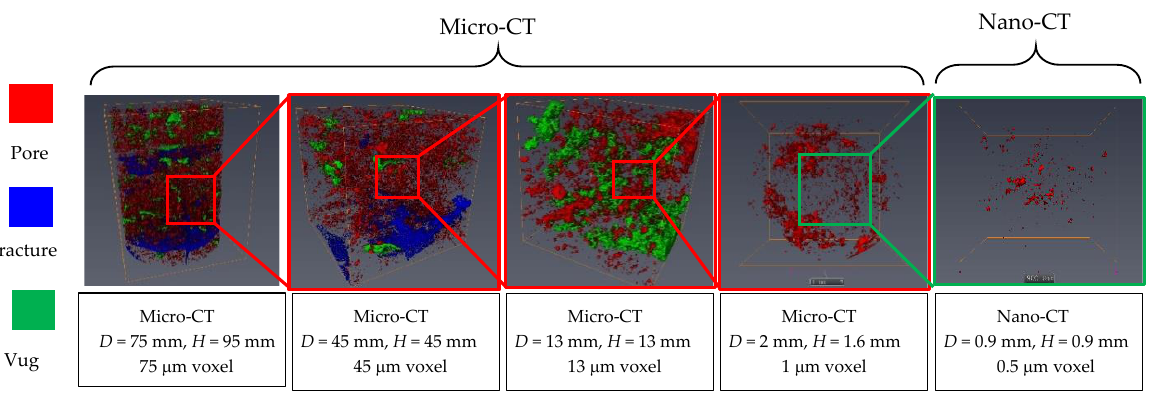
Figure 7. Spatial distribution of pores and cavities in representative cores at different scales (red indicates pores, blue indicates fractures, green indicates cavities).